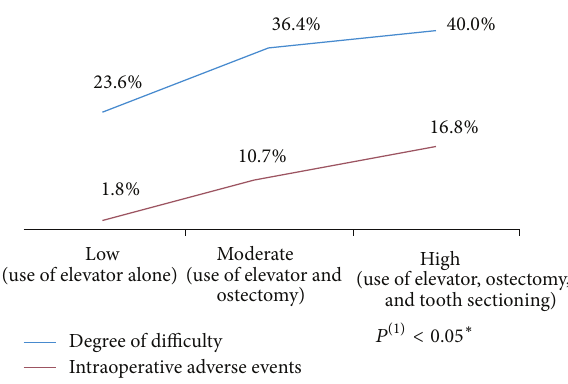
Figure 2: Analysis of the correlation between surgical difficulty and occurrence of intraoperative adverse